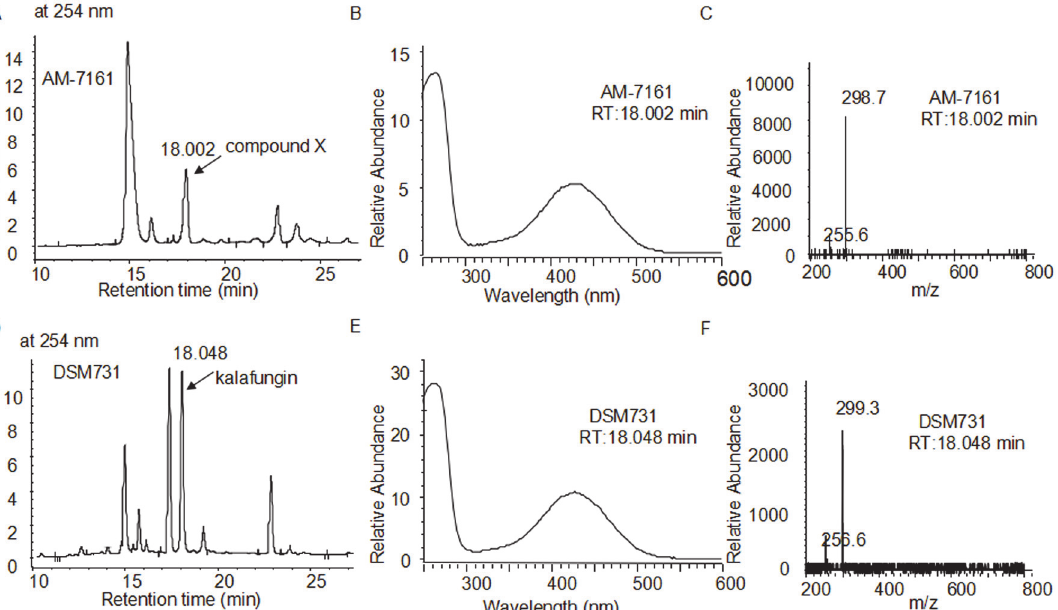
Fig 3. LC/MS analysis of the metabolites by the medermycin-producing Streptomyces sp AM-7161 (A, B and C) and kalafungin-producing Streptomyces tanashiensis Kala DSM731 (D, E and F). (A) and (D) UV absorption at 254 nm of metabolites by the wild type strain AM-7161 and DSM731. (B and E) Full-wavelength absorption spectra for two peaks in A at 18.002 min (compound X) and in D at 18.048 min (kalafungin) respectively. (C and F) MS spectra for compound X at 18.002 min in A and kalafungin at 18.048 min in D respectively.